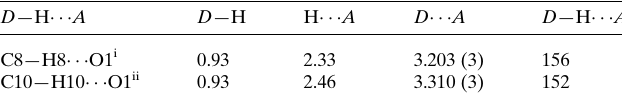
Table 1 Hydrogen-bond geometry (A˚ , (cid:2) ).